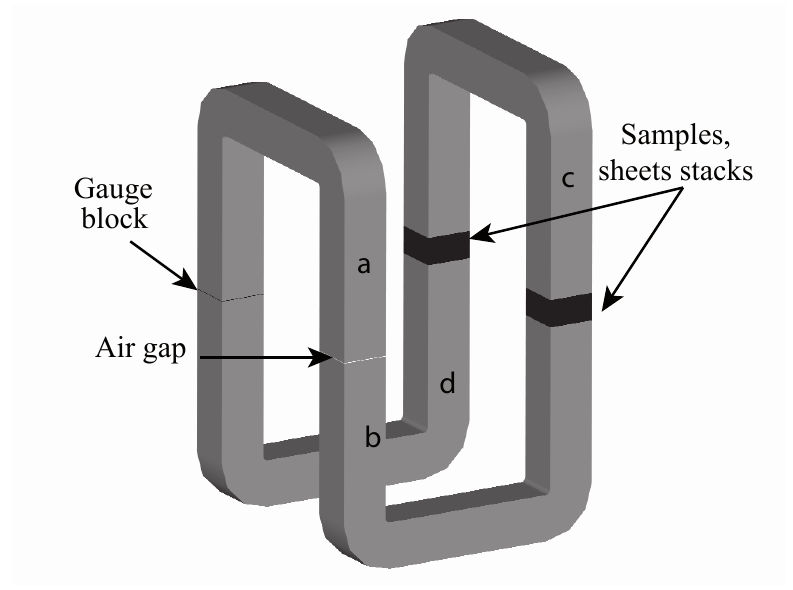
Figure 5. Test bench for static characterisation.